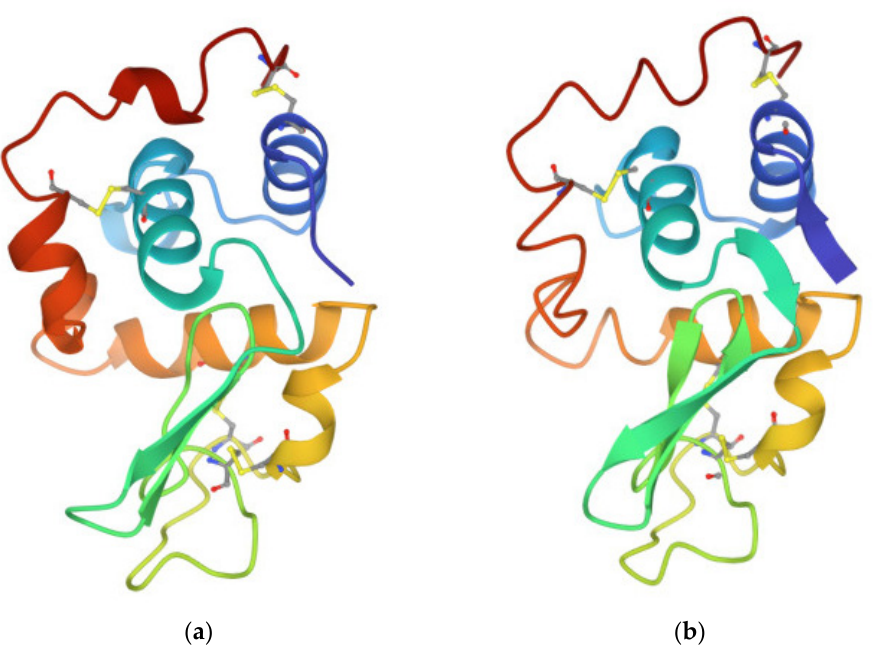
Figure 2. Structures of ( a ) human lysozyme 1LOZ and ( b ) hen egg yolk lysozyme 1LYZ, available from the RSCB Protein Data Bank archive [28].